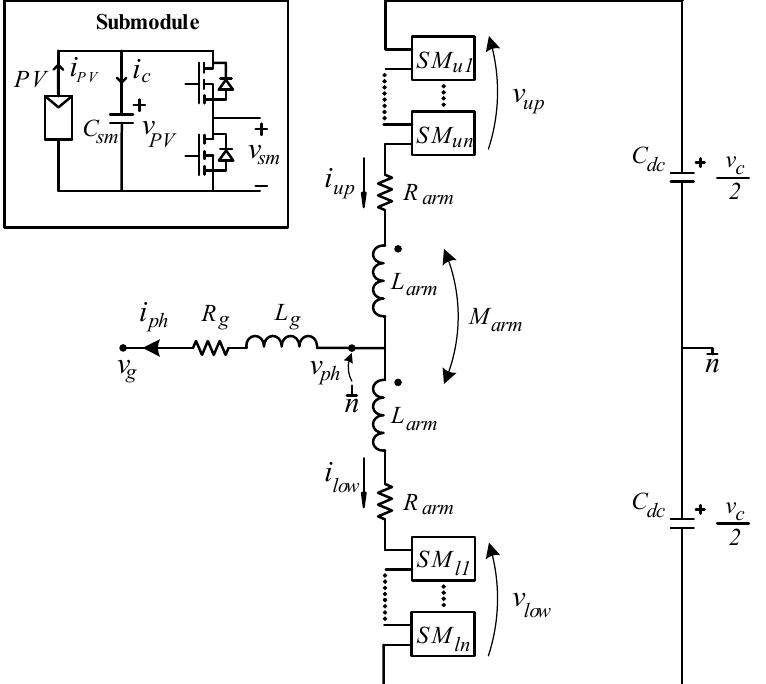
Figure 1. Topology of single-phase modular multilevel converter (MMC) with PV modules embedded in each submodule.